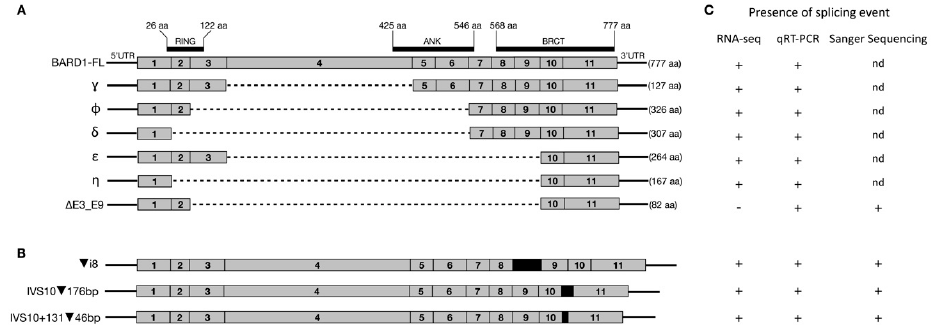
Figure 1. Schematic diagram of BARD1 and identified isoforms (selected). ( A ) Structure of full-length BARD1 ( BARD1 -FL) and six abundantly expressed alternative isoforms ( γ , φ , δ , ε , η , and Δ (E3_E9)). ( B ) Structure of identified splicing events. ( C ) Presence of identified isoforms as detected using various sequencing techniques. (nd)- not